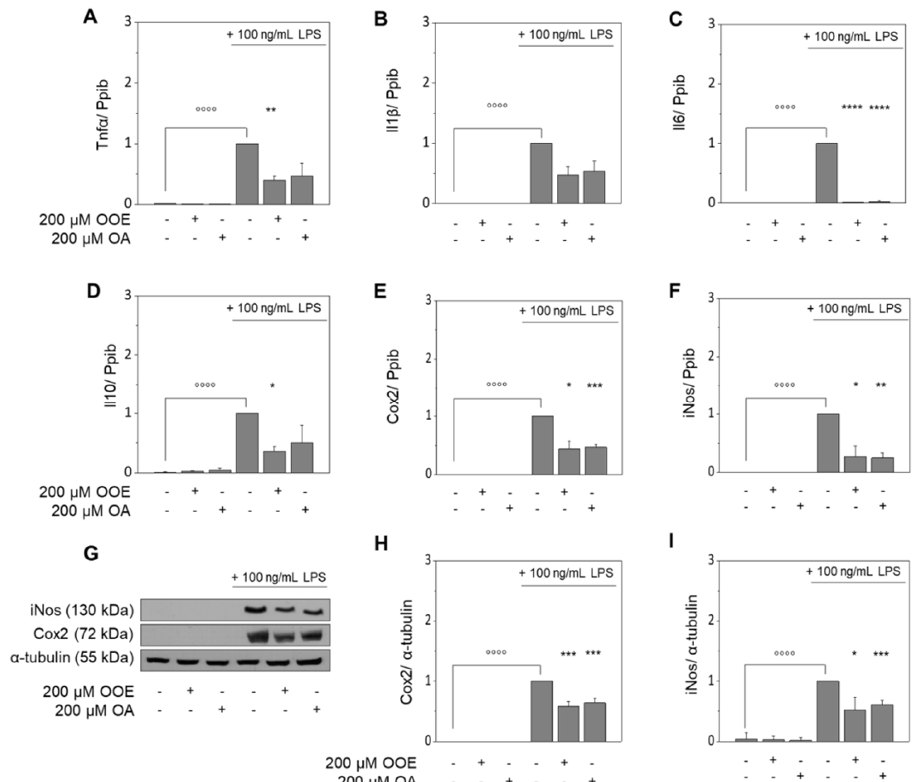
Figure 1. Effects of olive oil extract (OOE) and oleic acid (OA) on the expression of inflammatory markers. Extracts of olive oil and OA diminish LPS-induced expression of Tnf α , Il1 β , Il6, and Il10 mRNA ( A – D ), as well as iNos and Cox2 mRNA and protein expression ( E – I ) in murine RAW264.7 macrophages. Cells were pre-incubated with medium, 200 µ M OOE or 200 µ M OA for 4 h followed by co-incubation with 100 ng/mL LPS for an additional 20 h. Untreated control samples were cultured with serum-free medium for 4 h plus 20 h of serum-free medium; LPS-treated samples were defined as 1. Expression of mRNA and protein was normalized to Ppib or α -tubulin, respectively. Western blots shown here are representative examples of the blots used for densitometry. Data are shown as mean expression levels ± standard deviation of four ( A – F ) or six ( H , I ) independent biological replicates. Significant differences compared to the untreated control ( ◦◦◦◦ p < 0.0001) and to the LPS control (* p < 0.05; ** p < 0.01; *** p < 0.001; **** p < 0.0001) were obtained by repeated-measures (RM) one-way ANOVA tests.